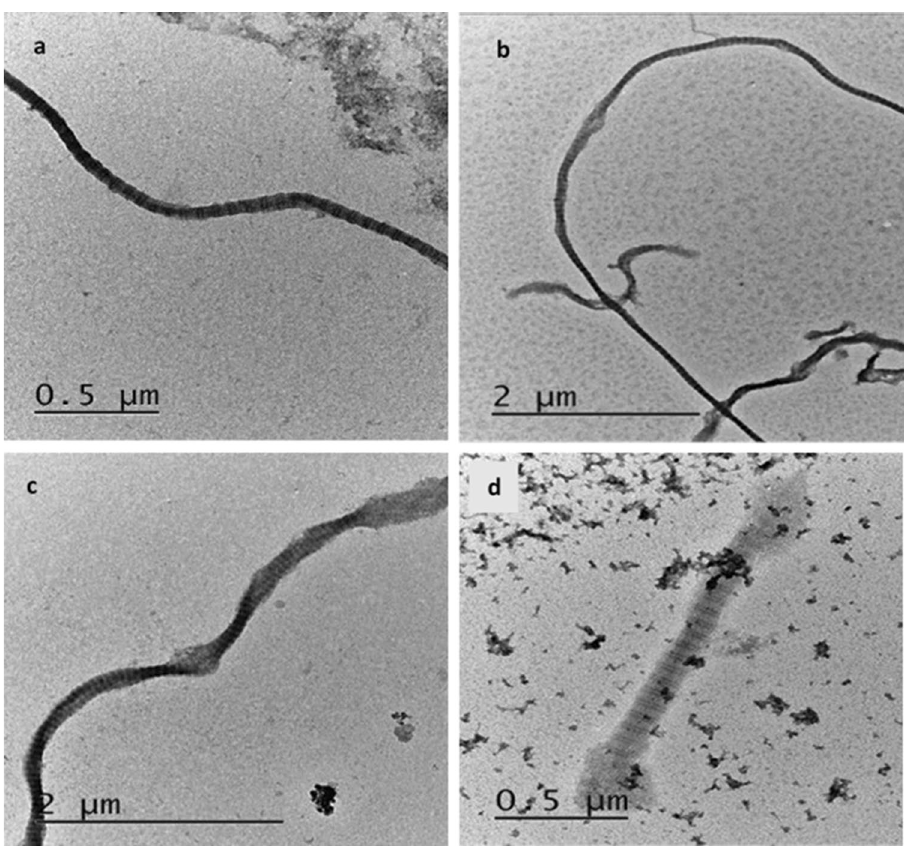
Figure 3. Examples of collagen classification from East Chisenbury (ECH31 and ECH36), demonstrating Unaltered ( a ), Slightly Beaded ( b ), Beaded ( c ), and Dumbbell ( d )